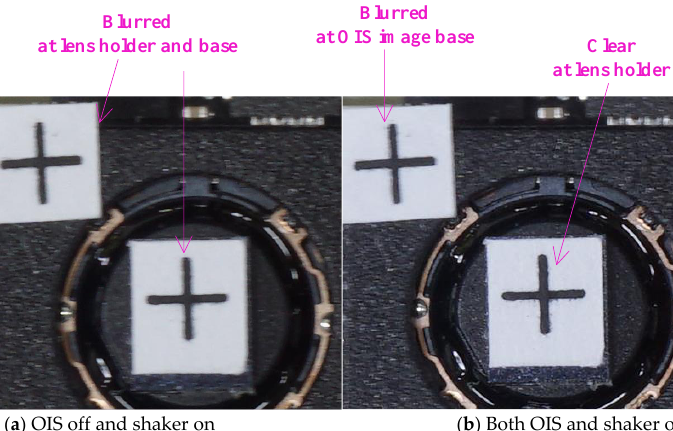
Figure 14. The uncontrolled and controlled photos of the lens holder in an OIS with an exposure time of 0.5 s.